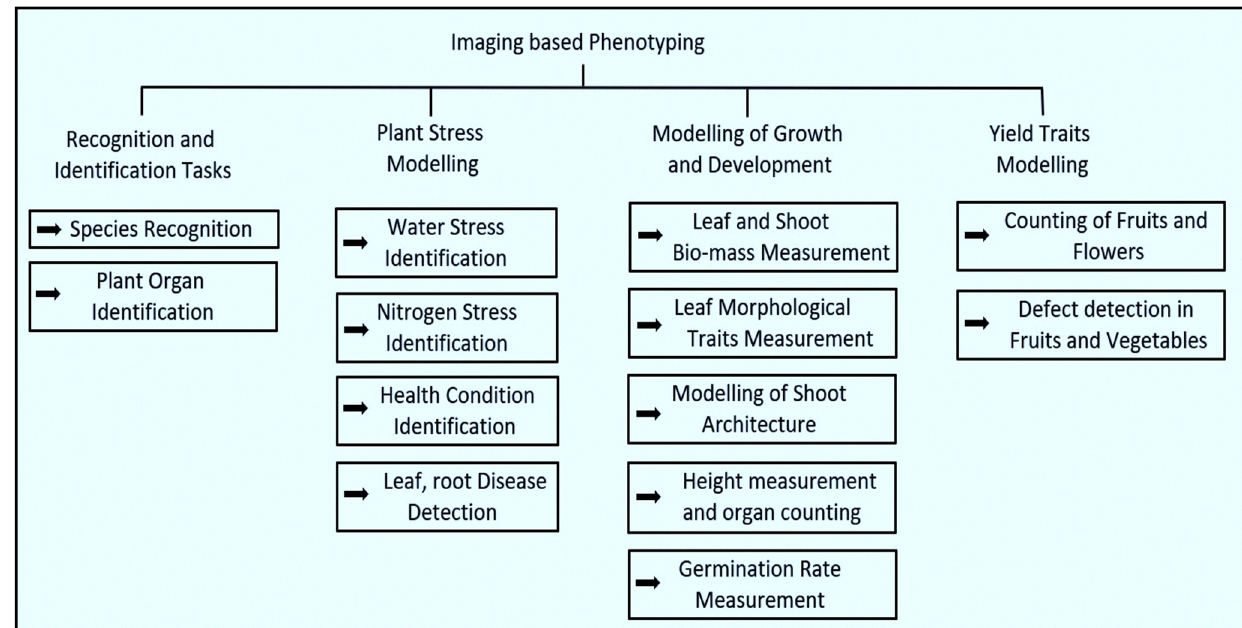
Figure 1. Computer-vision based plant phenotyping categories.